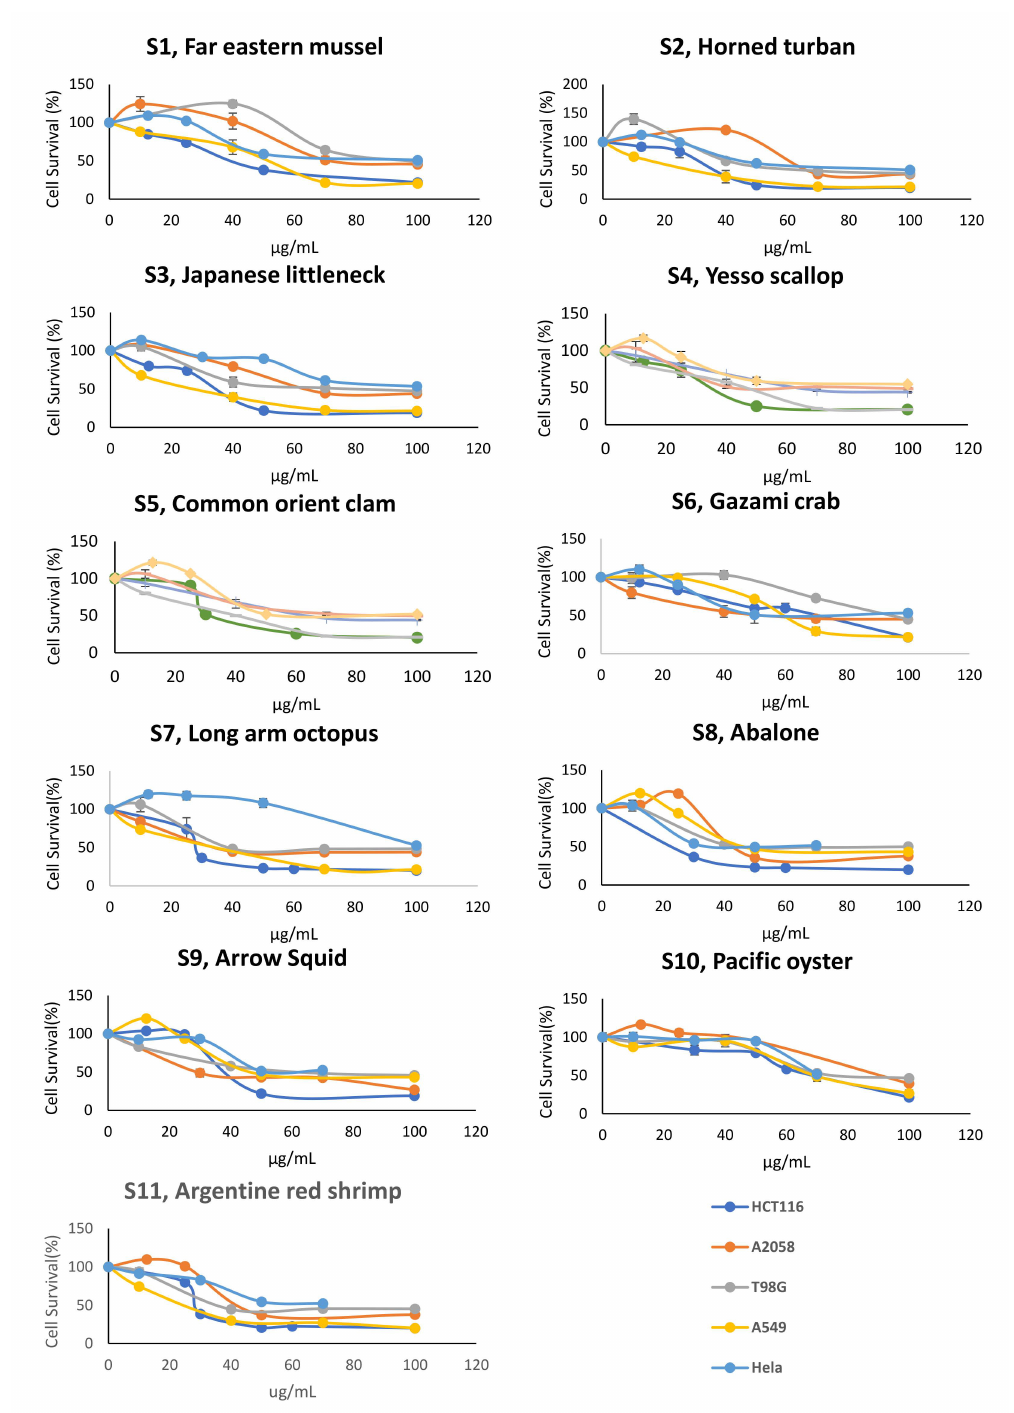
Figure 7. Cell survival analysis of shellfish lipids treatment to cancer cell lines. Values are mean standard ± standard deviation of three replicates for cell survival in % compared to control (0.5% DMSO) treatment for 24